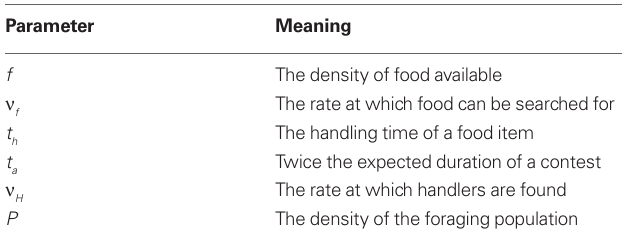
Table 1 | A summary of model parameters.